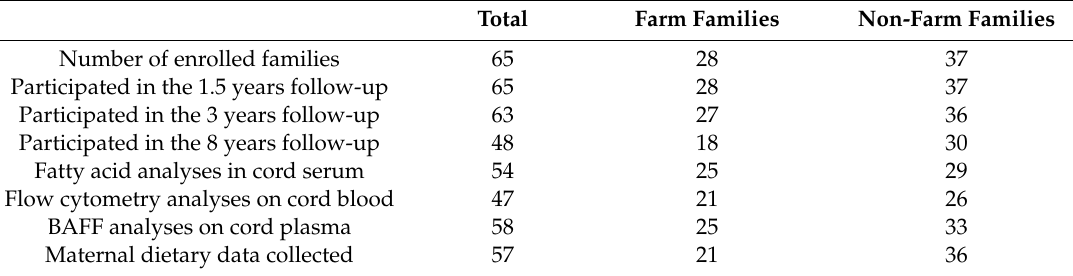
Table 1. Number of subjects involved in di ff erent parts of the